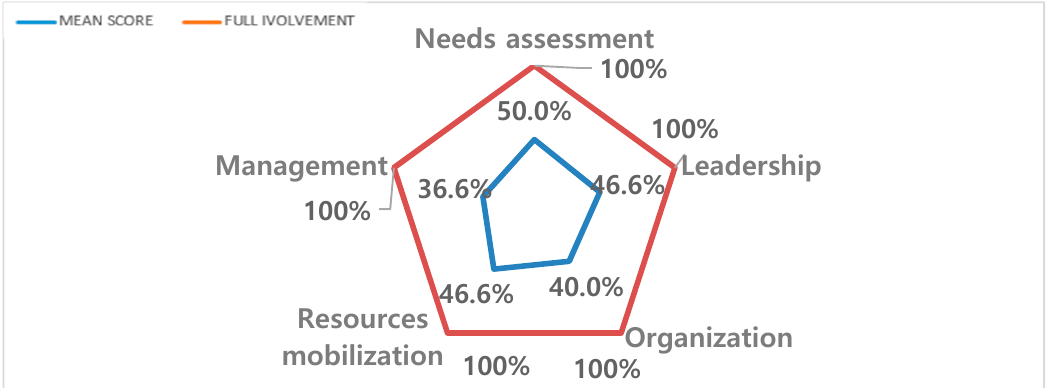
Figure 3. Level of involvement in included articles.